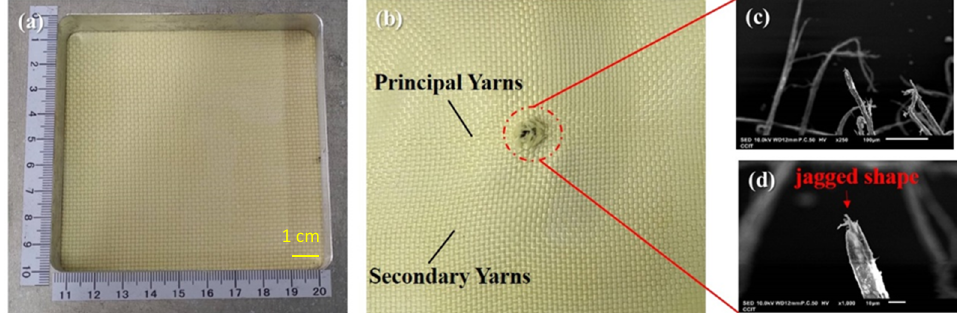
Figure 5. Observation of the single-ply ( a ) STF/Kevlar plate before the ballistic test; ( b ) failed fabric with STF/Kevlar fabrics plate ballistic test; ( c ) the close-up look of the failed fibres in ( b ); ( d ) the zoomed-in image of the failed fibers in ( c ).